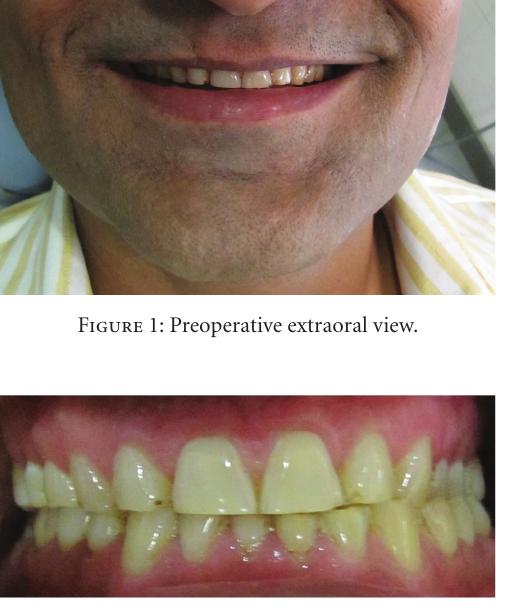
Figure 2: Preoperative intraoral view.